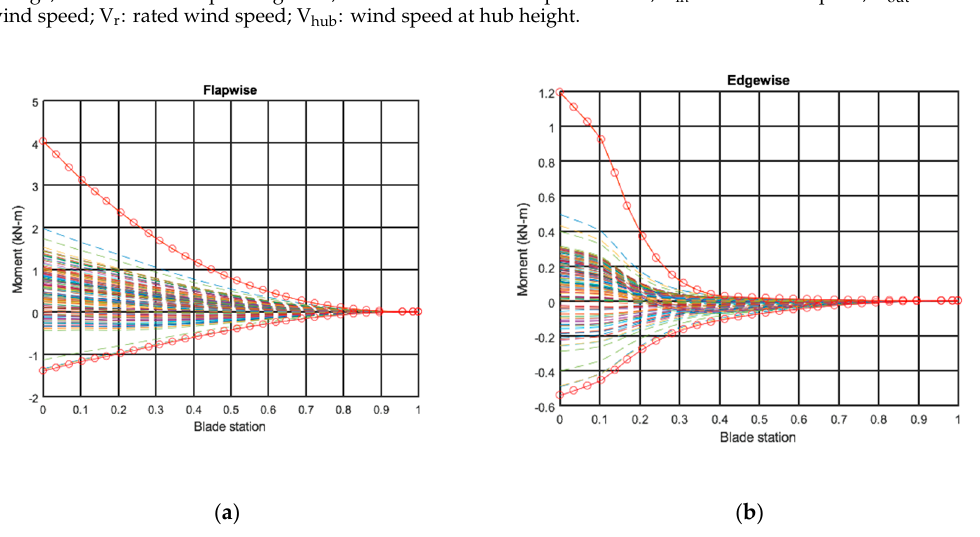
Figure 5. The simulated loads: ( a ) flapwise direction and ( b ) edgewise direction.